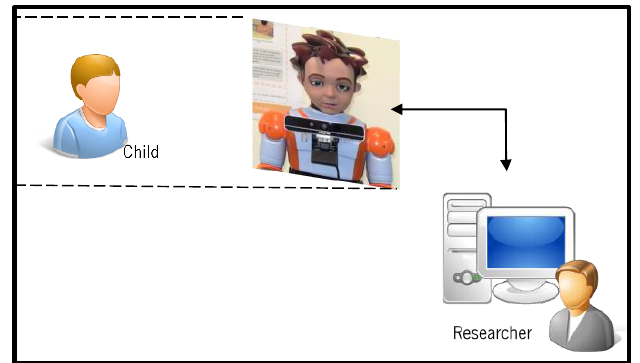
Figure 3. Experimental configuration: Child – ZECA – Researcher.